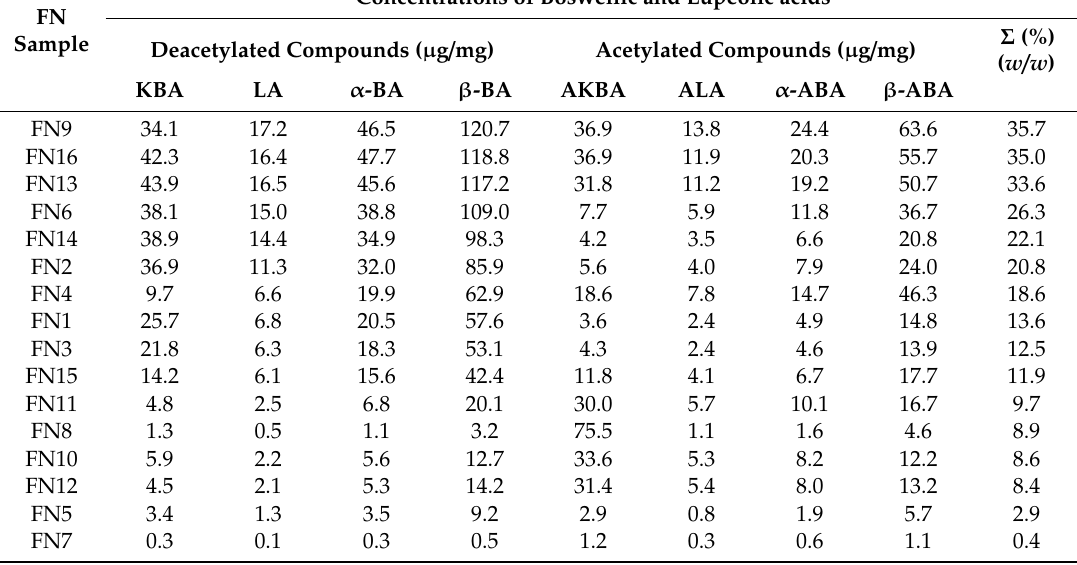
Table 1. Contents of boswellic and lupeolic acids in frankincense nutraceuticals (FN) quantified by HPLC-MS / MS